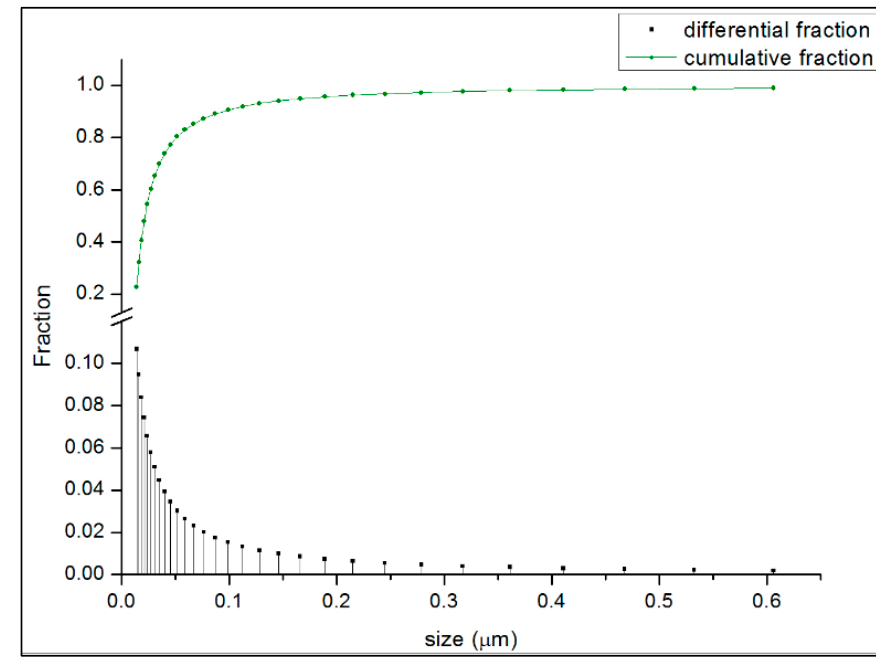
Figure 3. Particle size distribution obtained by dynamic light scattering.